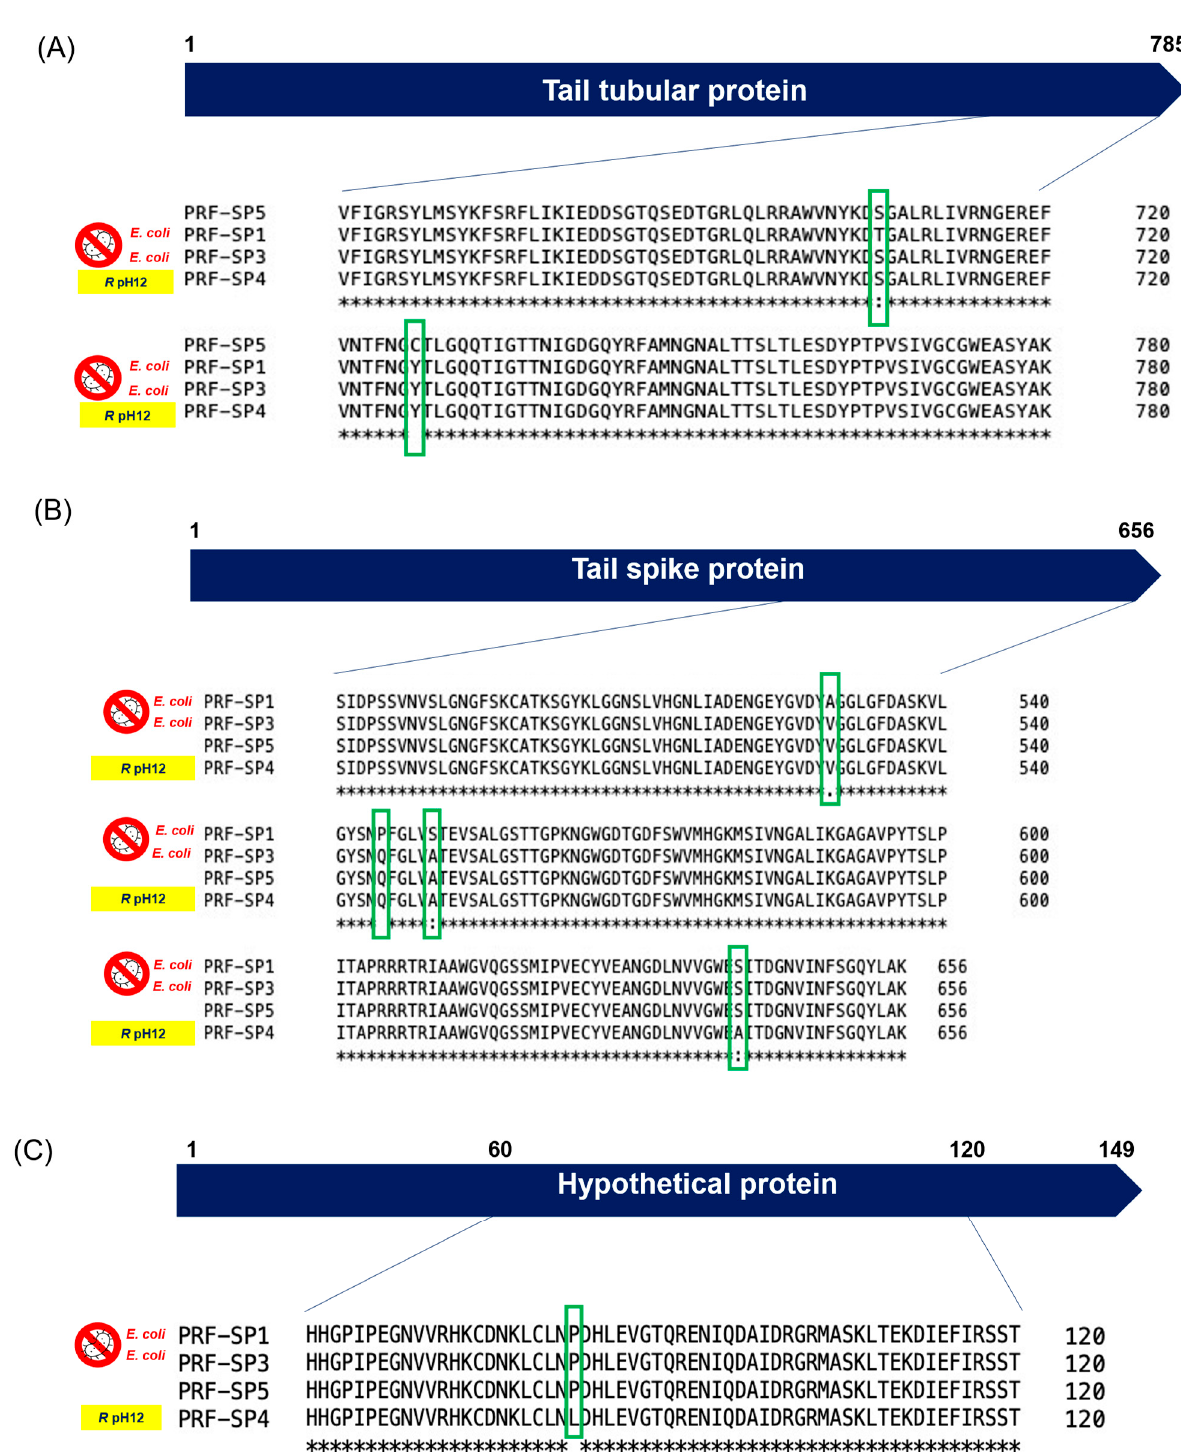
Figure 7. SNP analysis in phage protein sequences, and their phenotypic characteristics (PRF-SP4 is resistant to pH 12, while phages PRF-SP1 and PRF-SP3 lyse E. coli ). Green boxes indicate the muta- tions in the proteins. ( A ) Tail tubular protein, ( B ) Tail spike protein, and ( C ) Hypothetical protein.